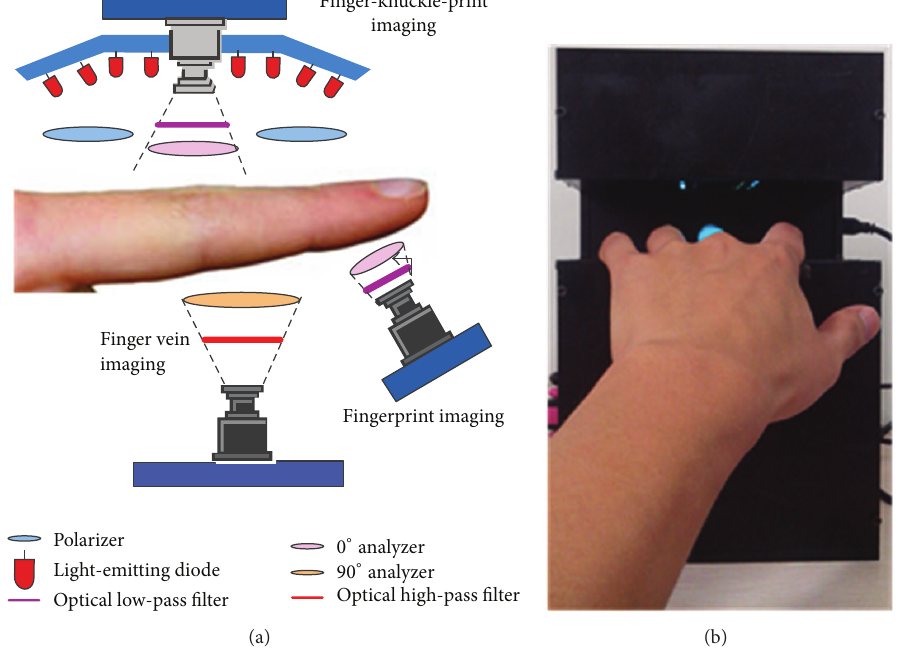
Figure 1: A homemade imaging system ((a) the proposed imaging principle and (b) an imaging